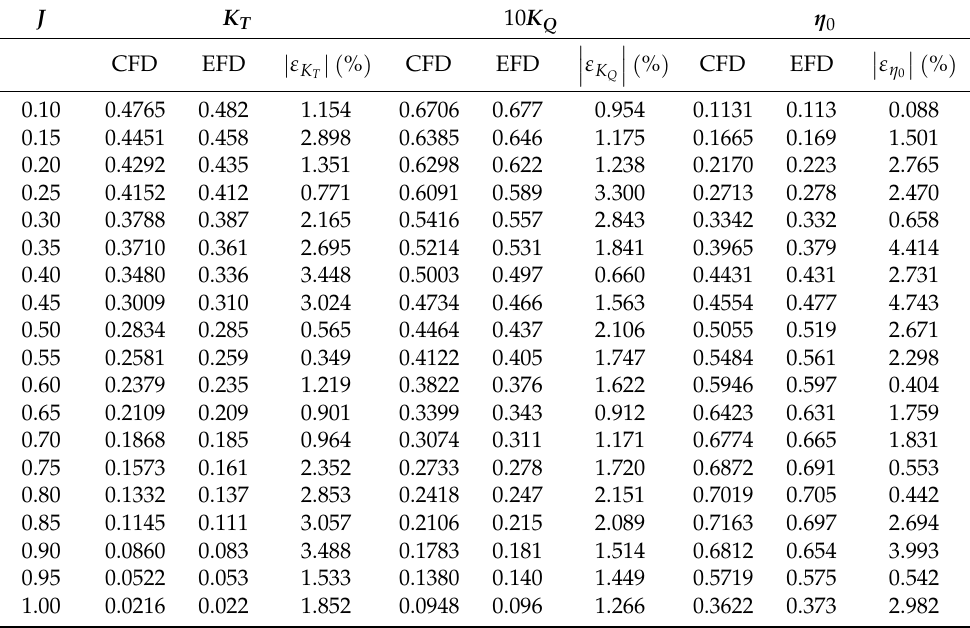
Table 6. Comparison between the computed and measured open water